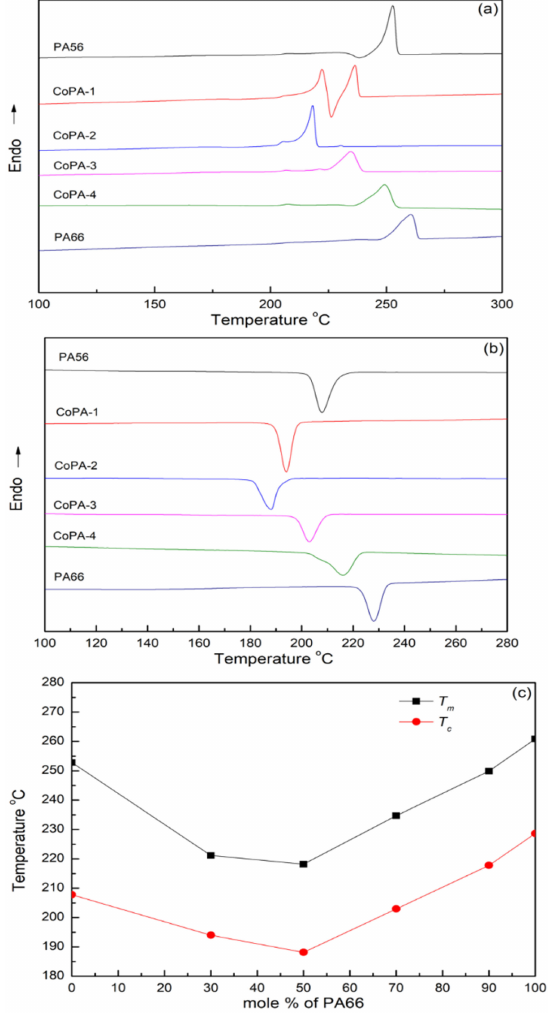
Figure 4. DSC thermographs of PA56/66 copolyamides; ( a ) heating curves ( b ) cooling curves ( c ) melting temperatures and crystallization temperatures. Table 4. The thermal properties of PA56/PA66 copolyamides by